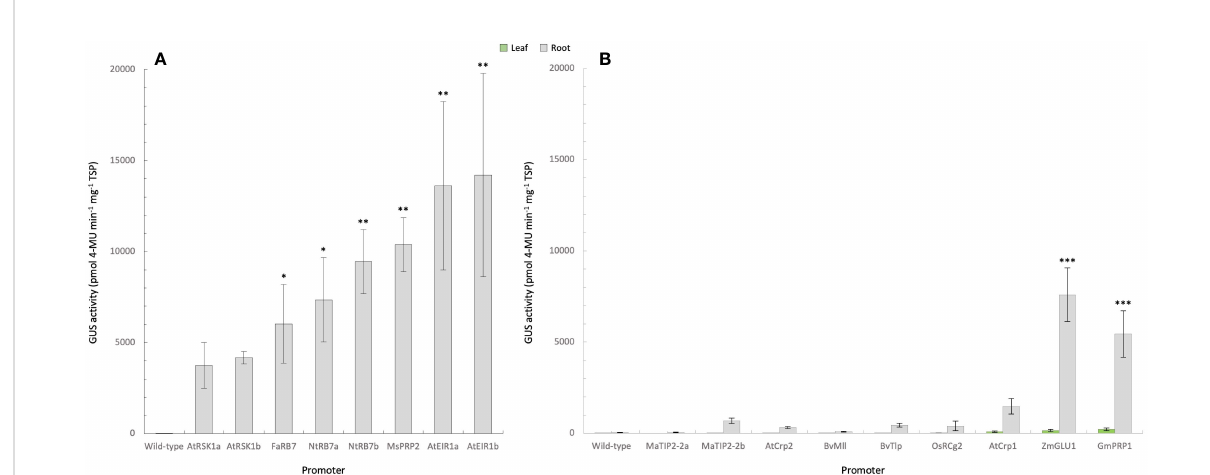
FIGURE 2 Quanti fi cation of GUS activity in leaf and root samples from promoter- uidA transgenic tobacco plants. (A) GUS activity was measured in the roots (Experiment 1) or (B) roots and leaves (Experiment 2 and 3) of transgenic promoter-uidA tobacco plants and reported as mean r mol 4- methylumbelliferone (MU) min -1 mg -1 of total soluble protein (TSP) from n biological replicates assessed in triplicate where n was as follows: Experiment 1; wild-type (n=5), Arabidopsis thaliana root-speci fi c kinase homolog 1a (AtRSK1a, n=4) and 1b (AtRSK1b, n=5), Fragaria ananassa Rb7 (FaRB7, n=4), Nicotiana tobacum Rb7a (NtRB7a, n=5) and b (NtRB7b, n=5), Medicago sativa proline rich protein 2 (MsPRP2, n=5), (A) thaliana ethylene insensitive root 1a (AtEIR1a, n=4) and 1b (AtEIR1b, n=3). Experiment 2; included wild-type (n=5), Musa acuminata tonoplast intrinsic protein 2a (MaTIP2-2a, n=3) and 2b (MaTIP2-2b, n=15), Beta vulgaris major latex-like protein (BvMll, n=14), (A) thaliana cryptic root-speci fi c promoter 1 (AtCrp1, n=14) and 2 (AtCrp2, n=15), Oryza sativa root-speci fi c cDNA 2 (OsRCg2, n=11), (B) vulgaris thaumatin-like protein (BvTlp, n=12), Glycine max proline-rich protein 1 (GmPRP1, n=14) and Zea mays b -glucosidase 1 (ZmGLU1, n=14). Non-parametric Kruskal-Wallis test and multiple comparisons with the Dunn ’ s Post-hoc test with p-values adjusted using the Benjamini-Hochberg method. Statistical difference with the wild-type asserted at *<0.05, **<0.01,